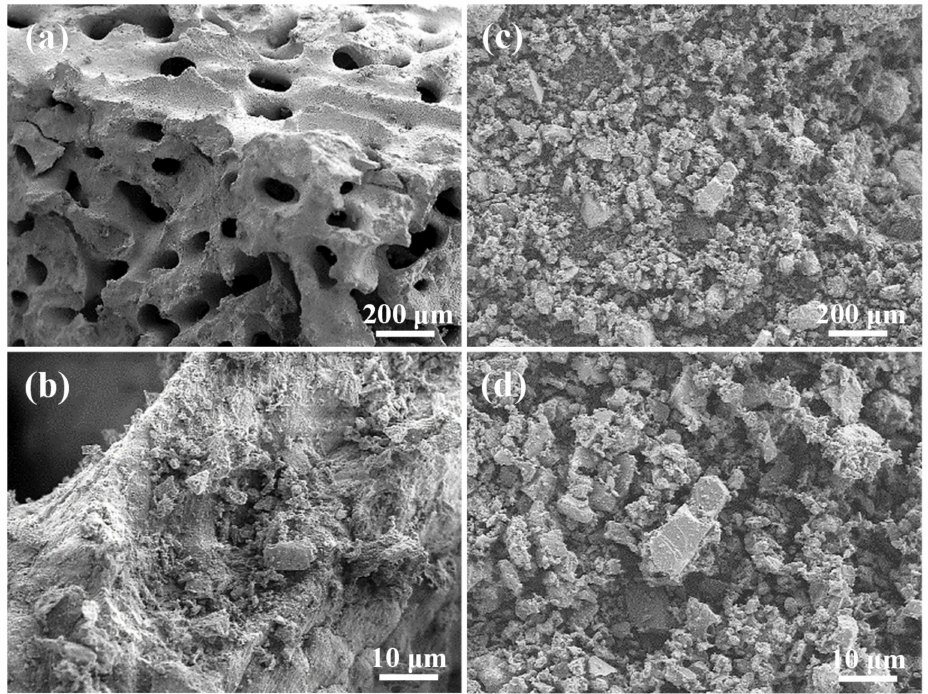
Figure 2. Comparisons between as-prepared coral and commercial coral calcium powder samples. ( a ) SEM image of the as-prepared coral, ( b ) a higher magnification SEM image of the as-prepared coral, ( c ) SEM image of the commercial coral calcium sample, and ( d ) a higher magnification SEM